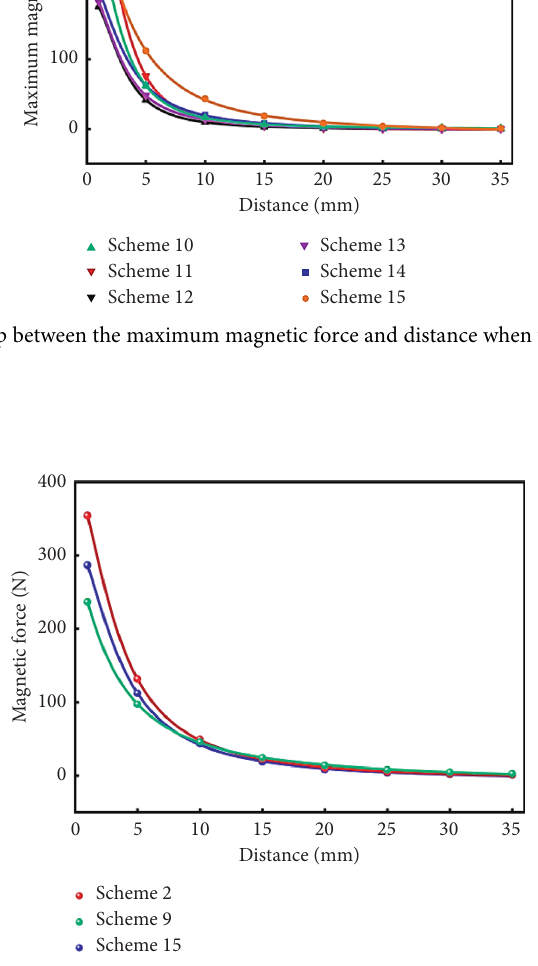
Figure 16: Relationships of the maximum magnetic force and distance of the monitoring point with fitting curves for three